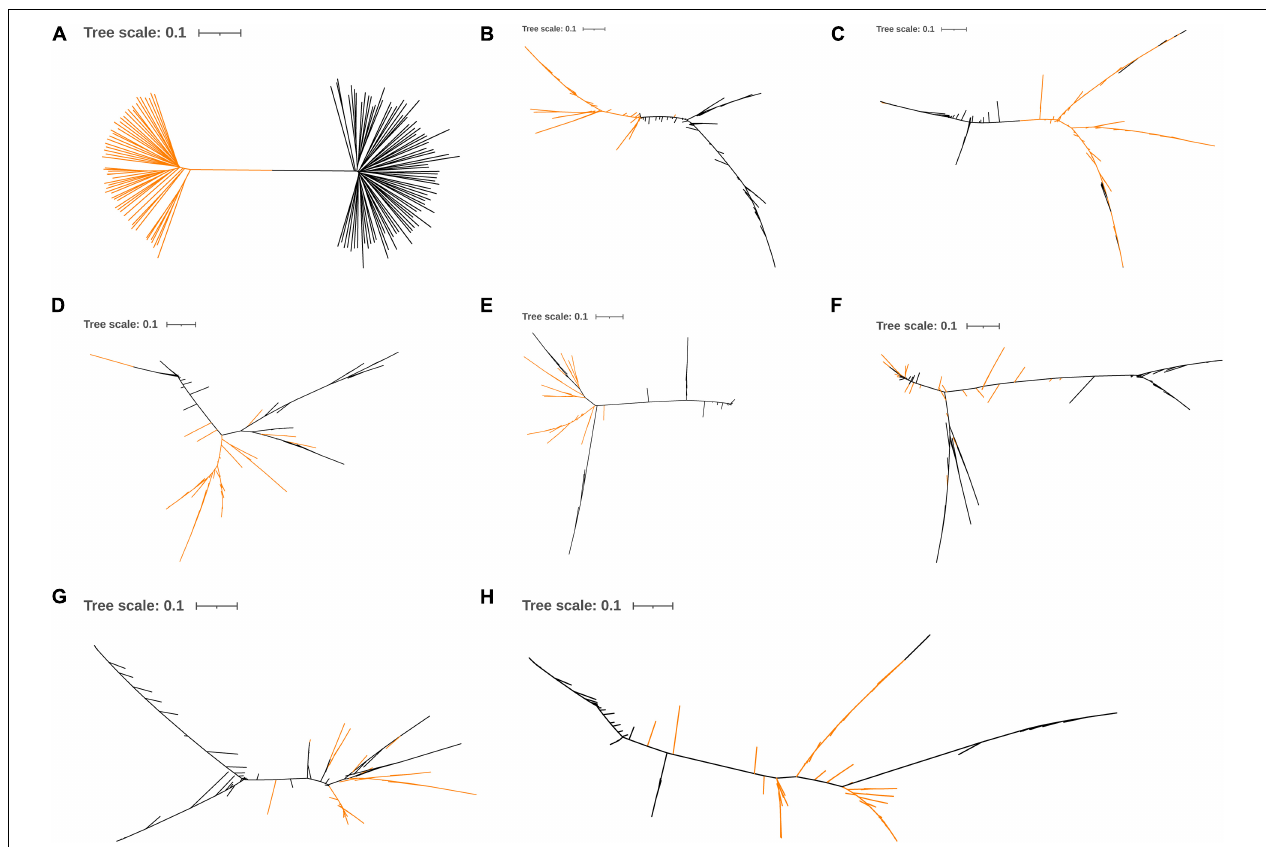
FIGURE 6 | Neighbor-joining tree based on the whole-genome SNPs (A) , candidate genes (B,C) , and 5 random 100-Kb regions (D–H) . The yellow line represents the Chahua chickens and Daweishan mini chickens, and the black line represents Line